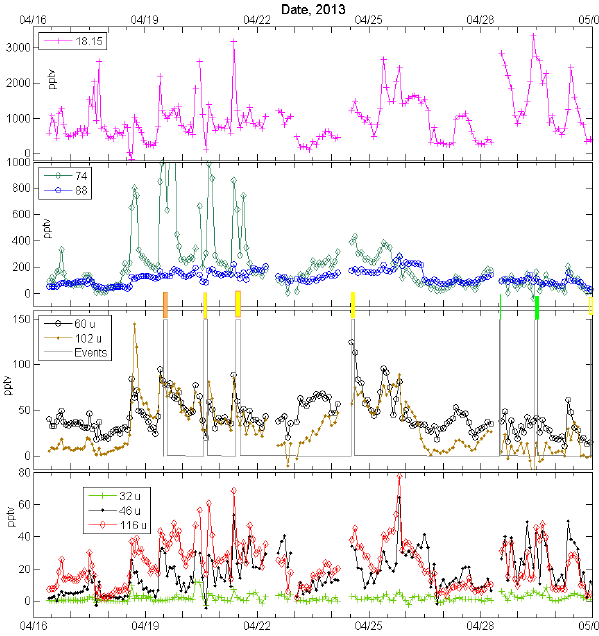
Figure 5. Concentration of ammonia and various amines (pptv) detected by AmPMS in Lamont, OK in 2013. Particle formation events are shown in the second and third plots and the squares indi- cate the intensity of the event increasing from green to yellow, to or- ange, and finally to red. From top to bottom: ammonia (18u) detec- tion was frequently in the 1000–2000pptv range; species detected at masses 74 and 88u (e.g., C4 and C5 amines, resp., or amides) had at times an unusually high presence, reaching sustained levels of 500pptv; both trimethylamine (60u) and 102 (C3 and C6 amines) were present in the many tens of pptv range; finally, methylamine (32u) was generally quite low, while both dimethylamine (46u) and mass 116 (C7 amines) could be up to 50pptv (10 to 20pptv, sus- tained). See Fig. S10b for more ambient data from this